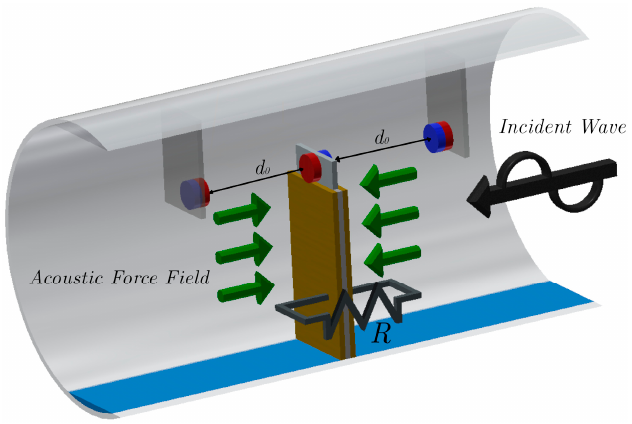
Figure 37. Quarter-wavelength tube AEHS concept with nonlinear restoring force arrangement.